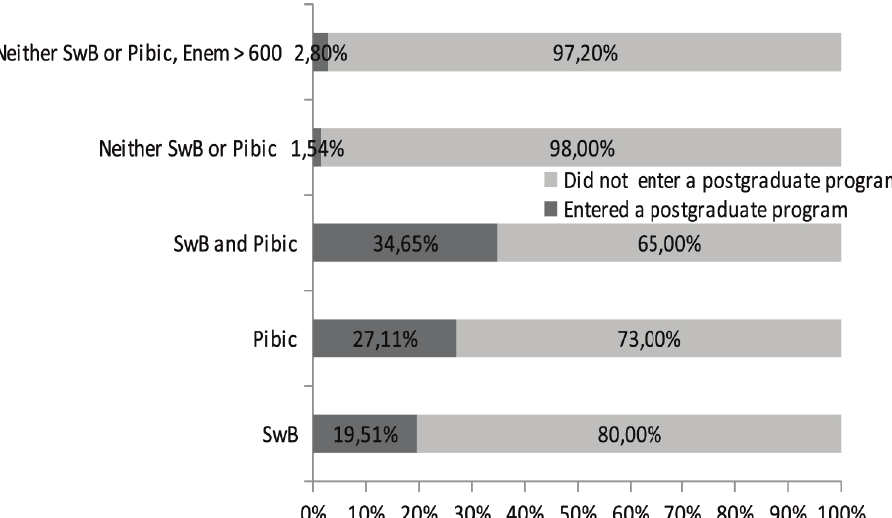
Figure 10 - Percentage of 2011/2012 cohort SwB undergraduate students that entered postgraduate system. (Pibic is a one-year undergraduate research program aiming to prepare students for postgraduate studies, Enem is a national end of high school exam. To apply for the SwB program after 2012 students had to achieve a score of > 600 in the